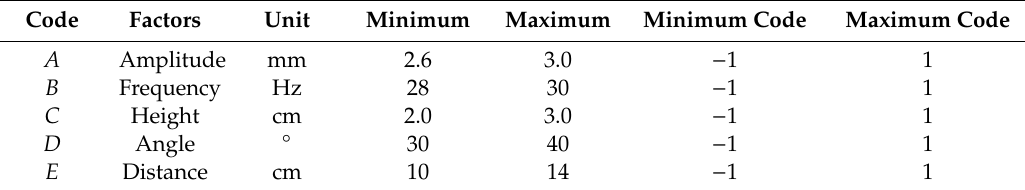
Table 7. Basic operation parameters in the separation experiments.